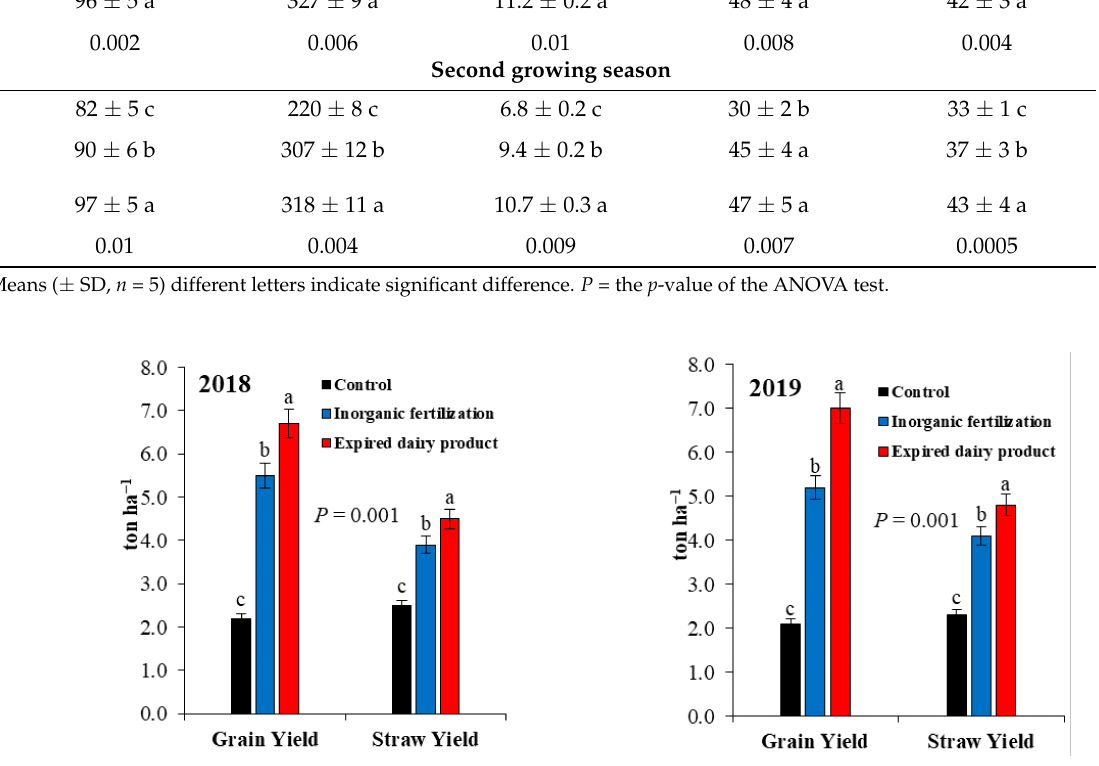
Figure 1. Effect of organic and inorganic fertilization on wheat yield during the two growing seasons. Means ( ± SD, n = 5) with different letters indicate significant difference. P = the p -value of the ANOVA